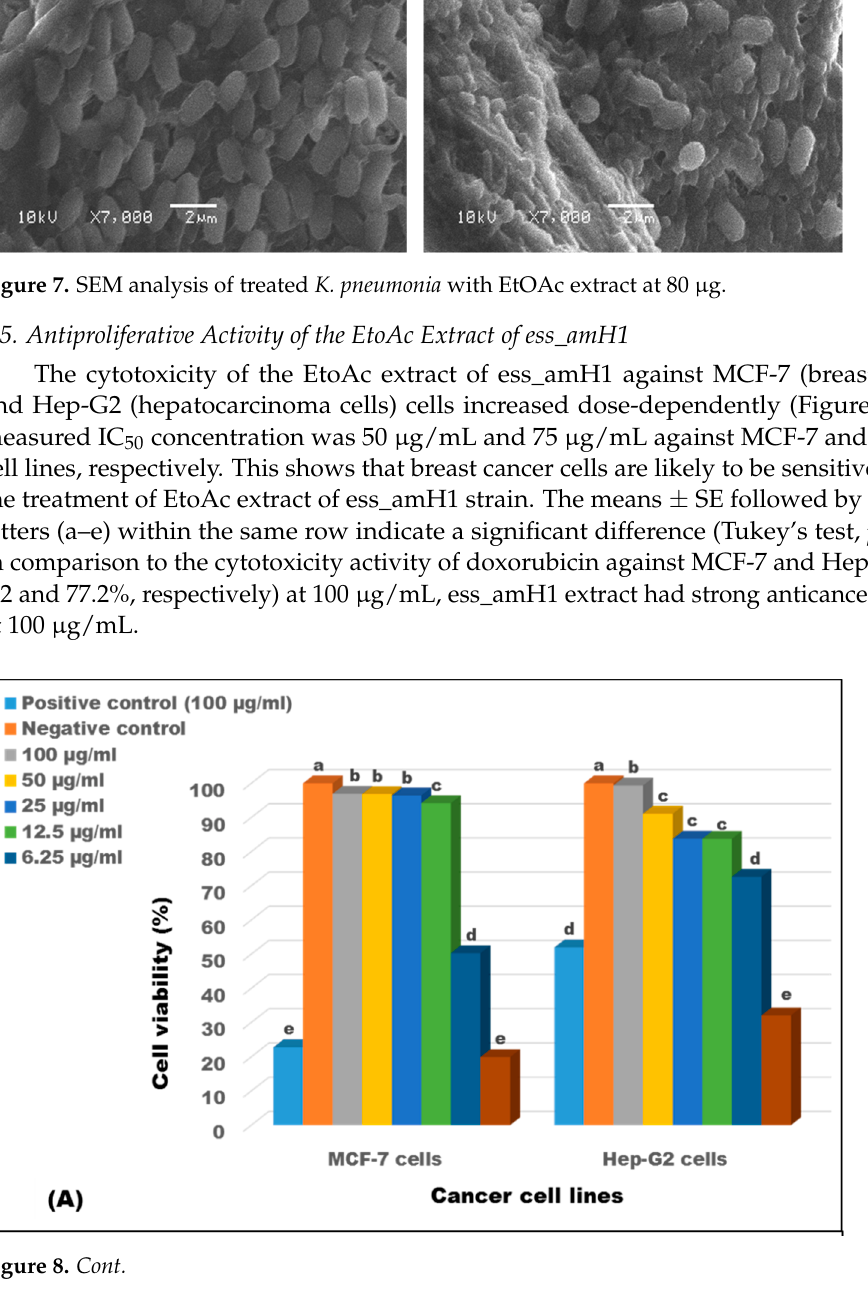
Figure 8. ( A ) Cell proliferation analysis by MTT assay. Different concentrations of EtOAc extract of Streptomyces sp. strain ess_amH1 were used to treat MCF-7 (breast cancer) and Hep-G2 (Hepatocar- cinoma cells) cancer cell lines. The means ± SE followed by different letters (a–e) within the same row are significantly different (Tukey’s test, p < 0.05). ( B ) Anticancer effect of with and without EtOAc extract of Streptomyces sp. strain ess_amH1. 4. Discussion